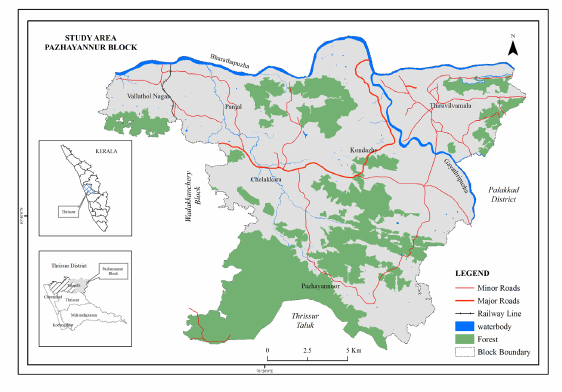
Figure 1. Location of the Study Area Figure 2. Land Suitability for Paddy Cultivation